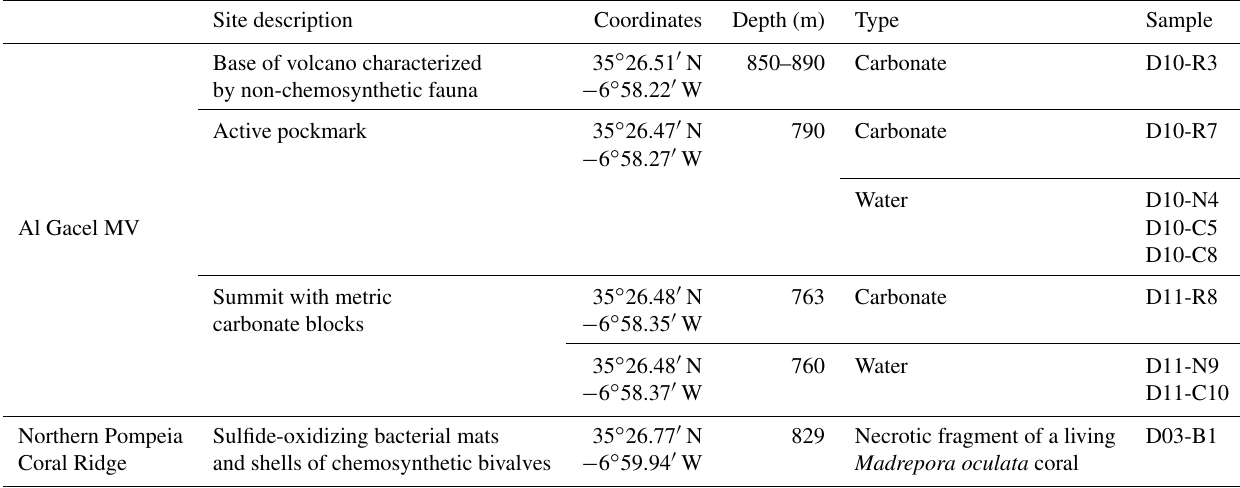
Table 1. General description and characterization of recovered samples for this study on the Al Gacel MV and northern Pompeia Coral Ridge. Please note that samples D10-R3 and D11-R8 were carbonates with embedded corals (see Fig. 7 for more